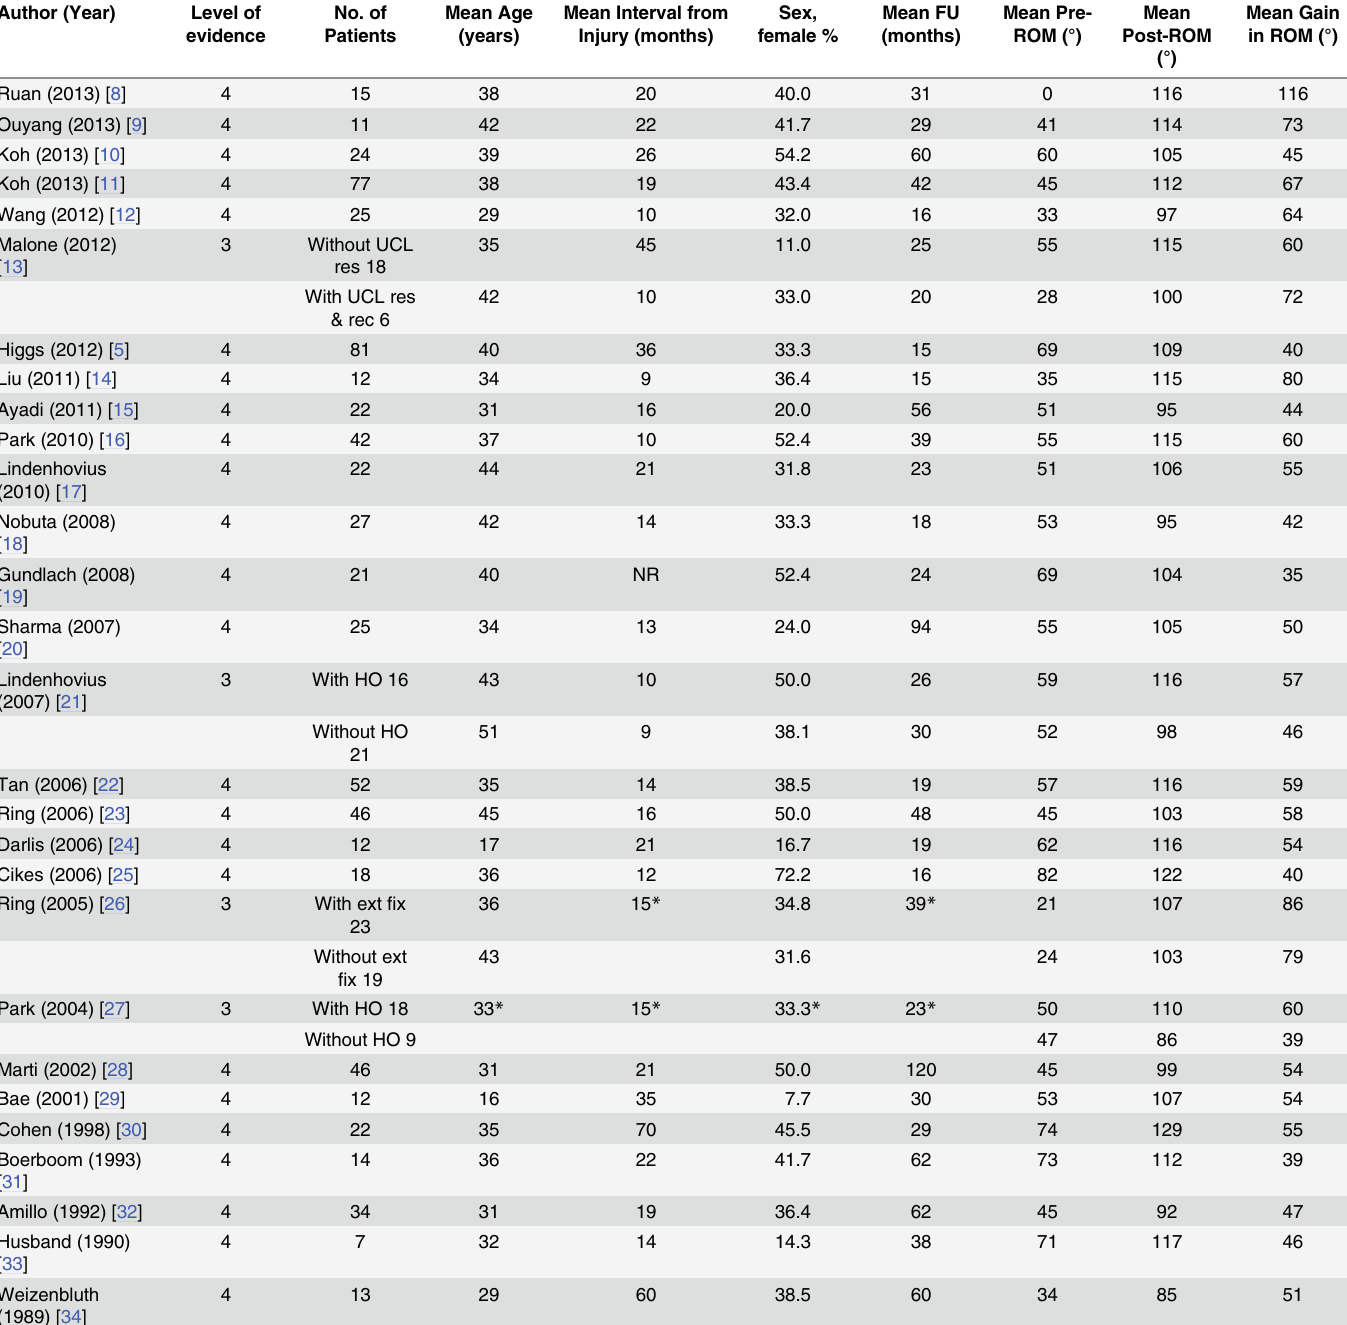
Table 1. Characteristics of selected studies and functional